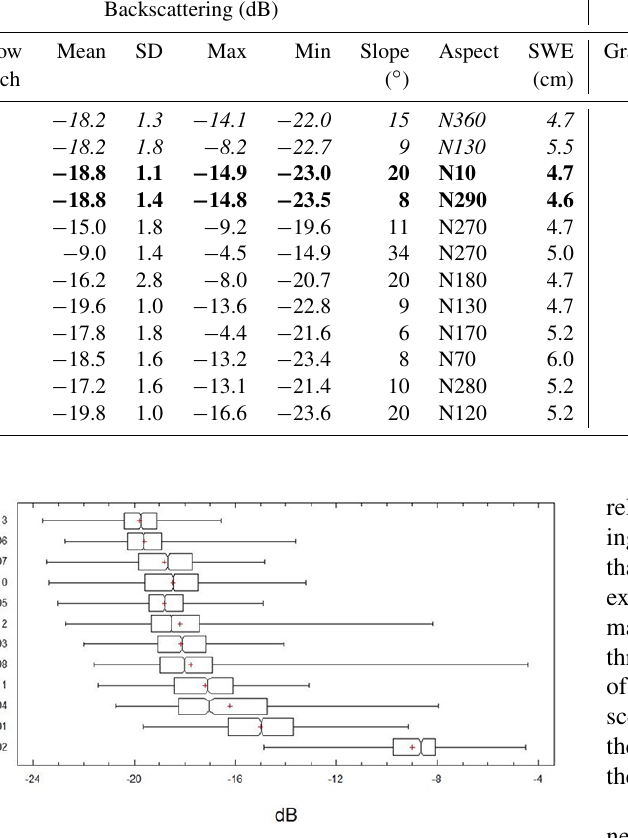
Figure 10. Box and whisker plots of backscattering of individual snow patches in the HH polarization scene from 12 January